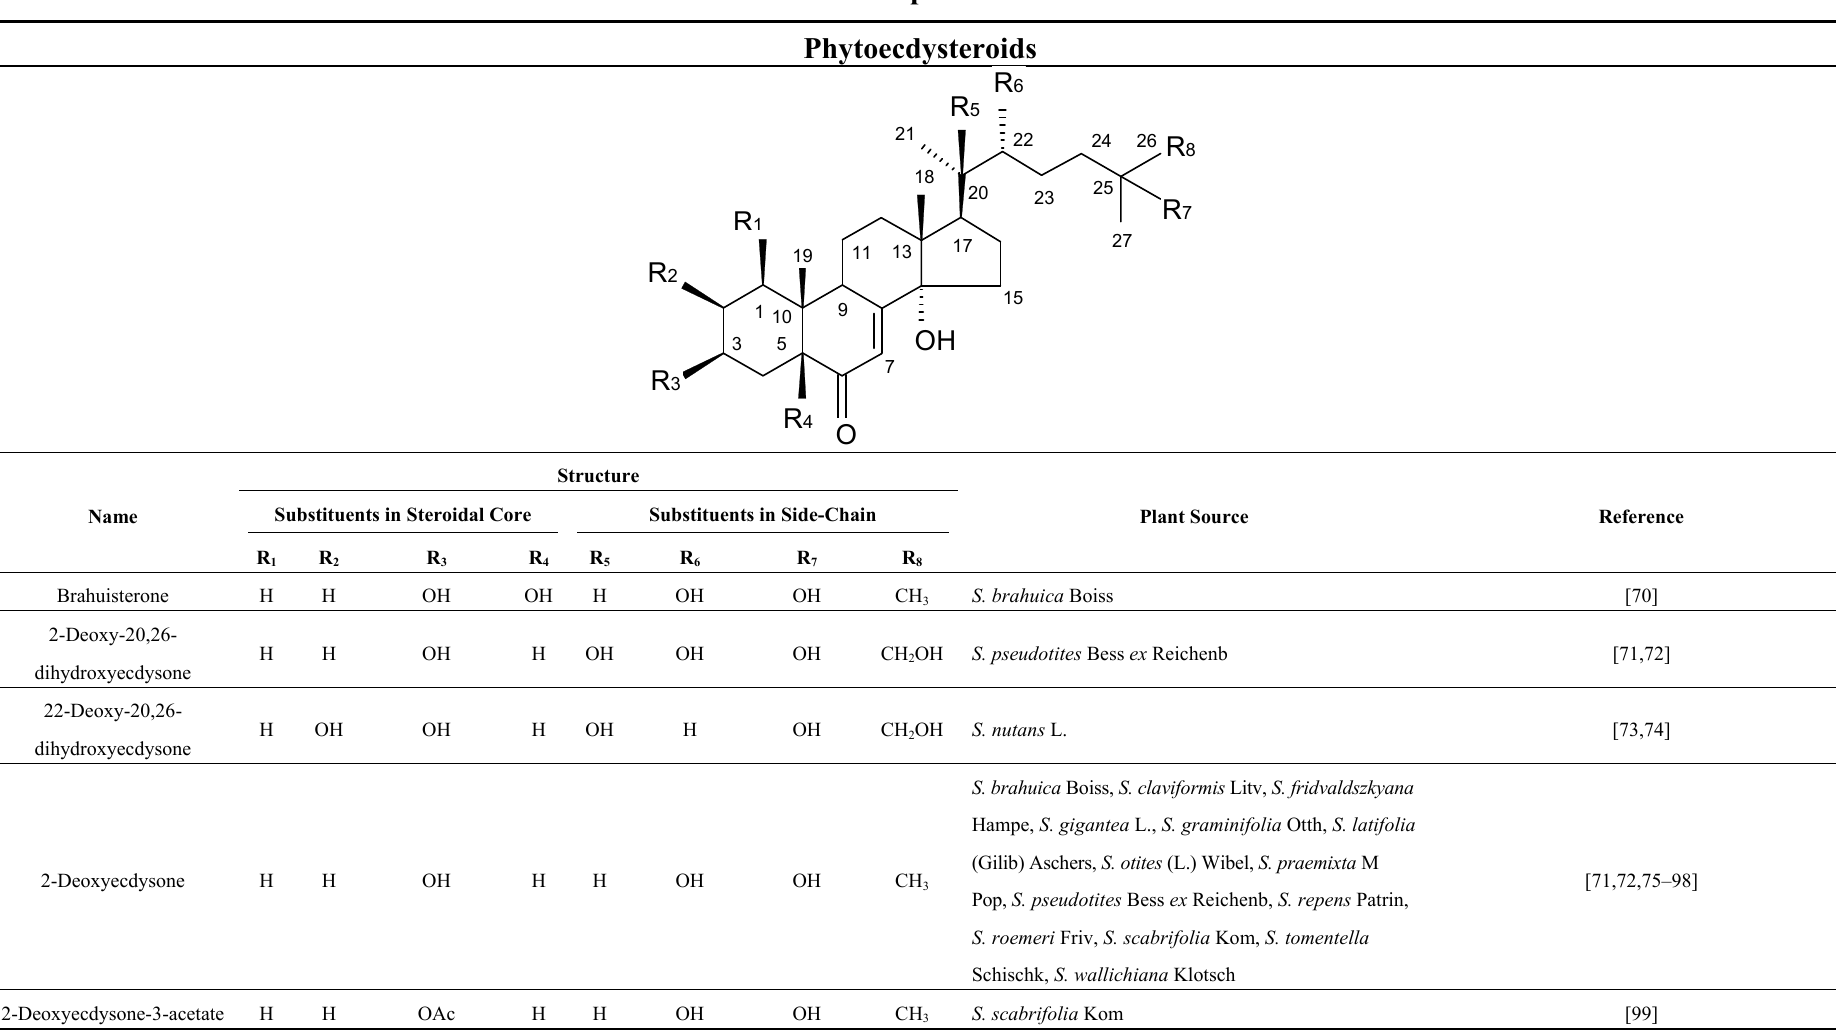
Table 1. Structures and Distribution of Secondary Metabolites in the Genus